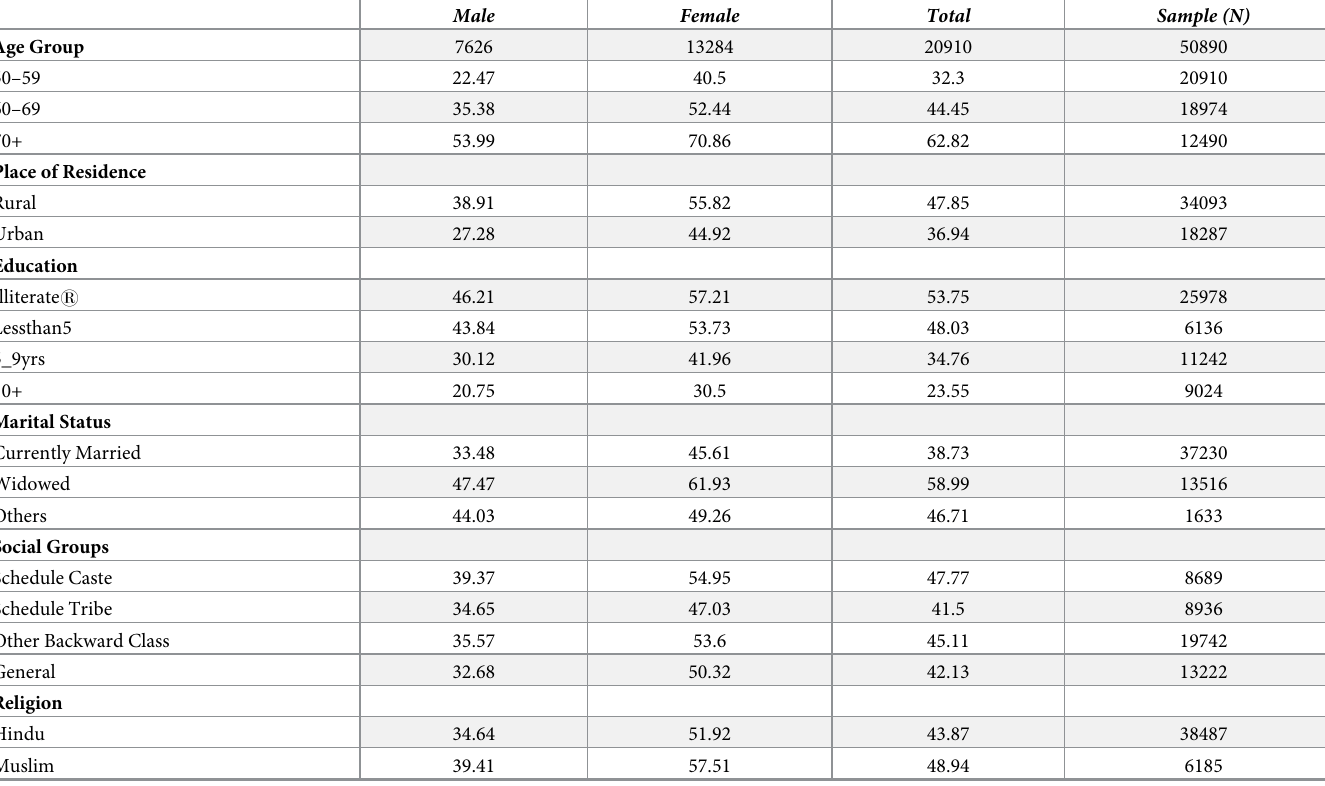
Fig 2. Gender differences in functional disability by regions among older adults in India (LASI 2017–18). https://doi.org/10.1371/journal.pone.0273659.g002 Table 1. Functional disability by socio-economic and wellbeing characteristics among older adults in India (LASI -2017-18). Male Female Total Sample